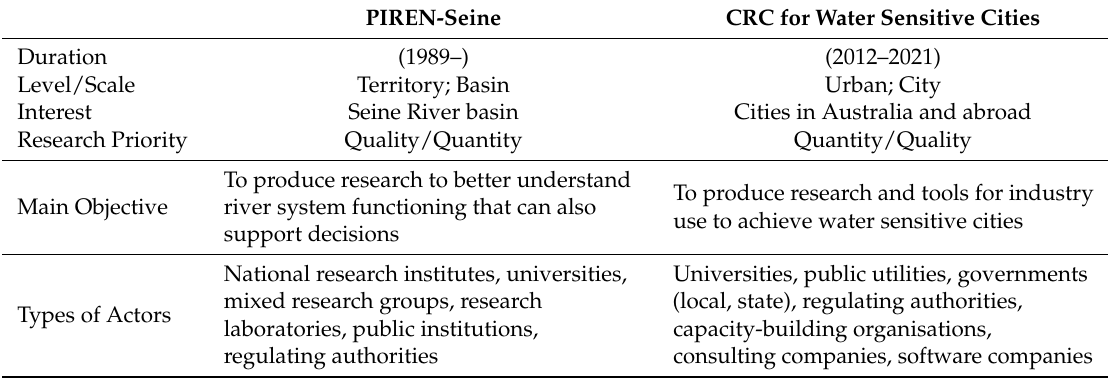
Table 1. Summary of Research